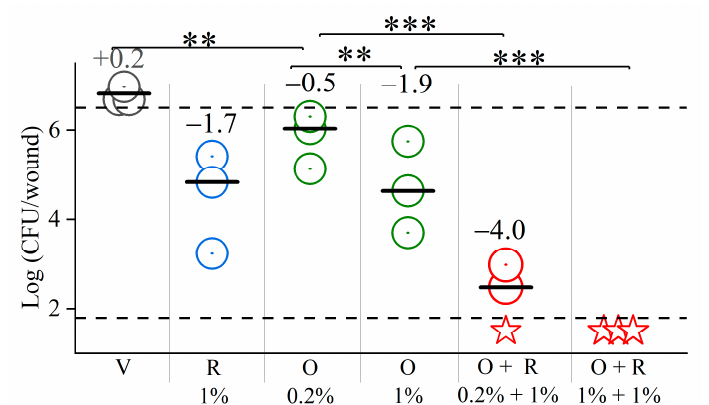
Figure 9. Excisional skin wound infection model. Plotted are colony forming units (CFU) counts of P. aeruginosa 27853 in each infected mouse ( n = 3 per group) upon topical treatment by a drug-containing hypromellose gel. V, vehicle (drug-free hypromellose gel); R, rifampin; O, C 14( ω 5) OOc 10 O. Percentages denote the drugs concentration ( w/v ) in the gel. The numbers above each column indicate the change from the initial inoculum (represented by the upper dashed line). Horizontal bars specify the median. The limit of detection is represented by the lower dashed line (log 10 50 CFU/mL = 1.69). Statistically significant differences are denoted by double (**) and triple (***) asterisks for p -value < 0.05 and p -value < 0.005, respectively. Red stars denote lack of detectable CFU.